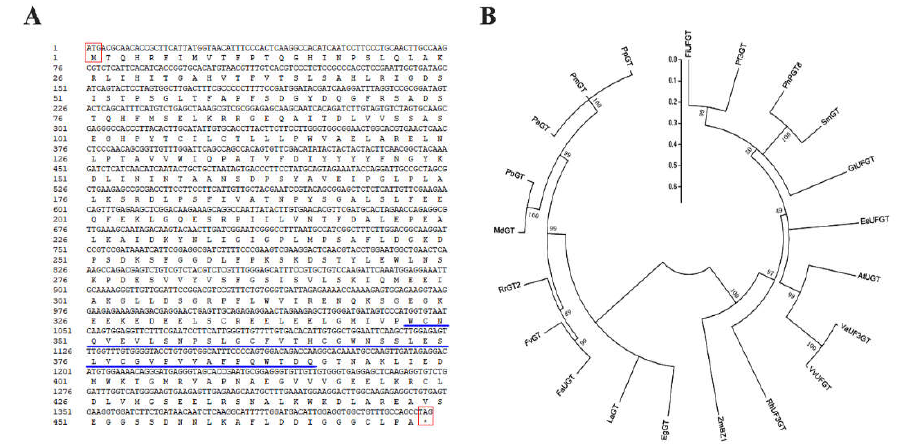
Figure 1. cDNA sequence analysis and phylogenetic tree analysis of the RrGT2 gene. ( A ) cDNA sequence of RrGT2 and its deduced amino acids. The red box shows the start codon and the termination codon as well as the amino acids they encode. The PSPG domains are underlined by the blue line. ( B ) Phylogenetic tree of amino acid sequences of RrGT2 and GT members from other plant species. The tree was constructed by the neighbor-joining method using MEGA 5.0 software. The branch numbers represent the percentage of bootstrap values from 1000 sampling replicates and the scale indicates the branch lengths. The gene names from various plant species and the NCBI GenBank